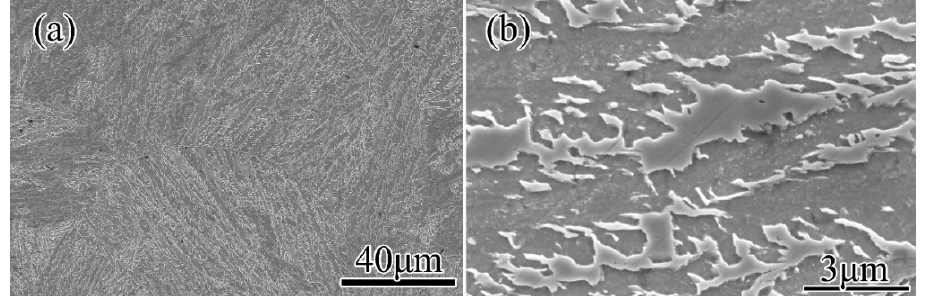
Figure 1. Microstructures of as-received material.